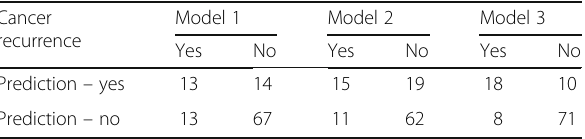
Table 2 Comparison of three confusion matrices generated by three machine learning models trained using tumor-related features (Model 1), emphysema-related features (Model 2), and combined image features (Model 3) to predict the risk of lung cancer recurrence